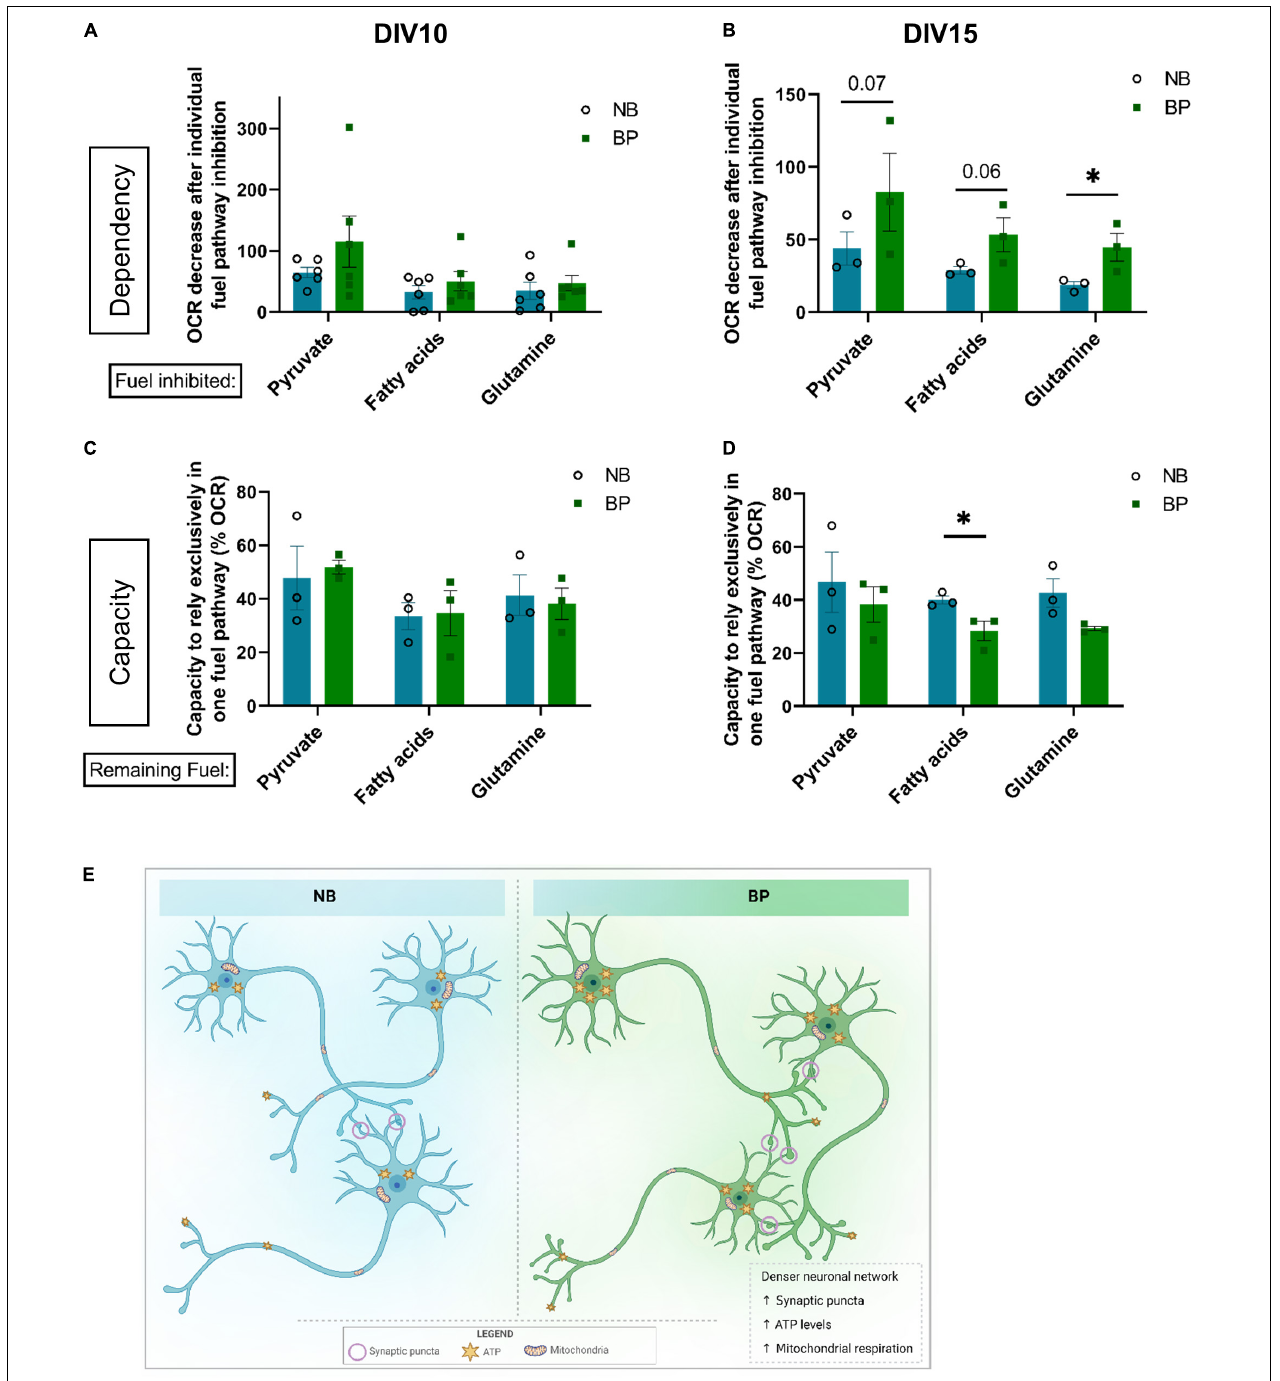
FIGURE 4 | Mouse neurons maintained in BP medium show higher plasticity to use different energy fuel sources. OCR fraction quantification referred to the dependency of neurons maintained in NB or BP medium to rely on one of the three main fuel pathways: pyruvate, fatty acids, or glutamine on individual treatment with inhibitors of each fuel pathway: UK-5099, etomoxir, and BPTES, respectively. Measurements were performed at DIV10 (A) and DIV15 (B) ( n = 3–6 biological experiments). Percentage of OCR regarding the capacity of neurons maintained in either NB or BP medium to rely exclusively on one of the three fuel pathways: pyruvate, fatty acids, or glutamine. Measurements were performed at DIV10 (C) and DIV15 (D) ( n = 3 biological experiments). All graphs show means ± SEM, determined using the ratio paired student’s t -test, ∗ p < 0.05. (E) In comparison with mouse primary neurons maintained in NB, neurons maintained in BP medium, after DIV4, showed a denser neuritic network correlated with increased expression of synaptic markers and increased synaptic puncta density. Bioenergetically, neurons maintained in the BP medium also presented increased ATP levels, which correlated with an increased mitochondrial respiration capacity.